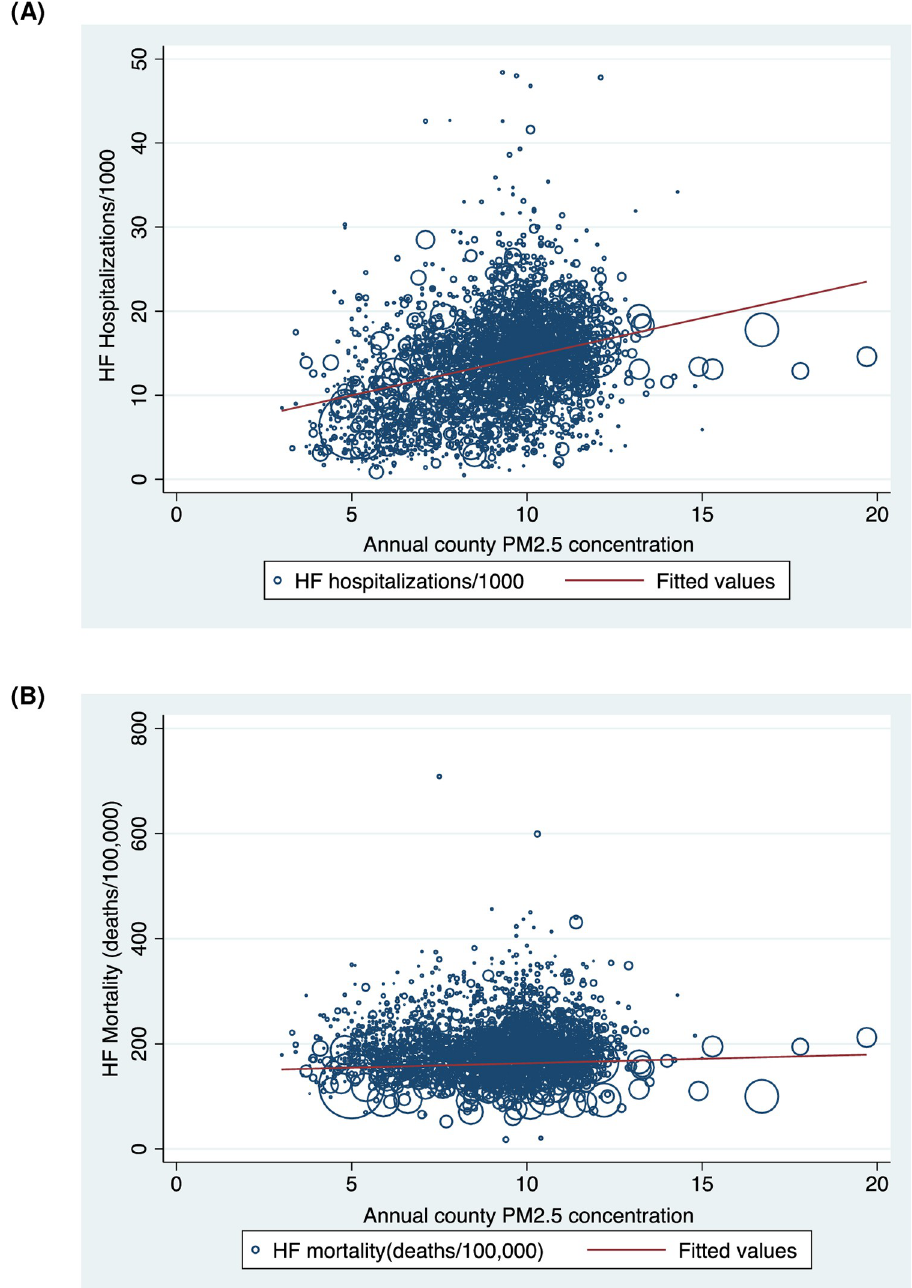
Fig 1. Correlation of county PM 2.5 concentration levels and HF outcomes. Analytic-weighted scatter plots showing correlation of PM 2.5 concentration levels with (A) heart failure hospitalizations (r = 0.41) (p < 0.05) and (B) heart failure mortality (r = 0.08) (p < 0.05), across 3135 counties of the United States.